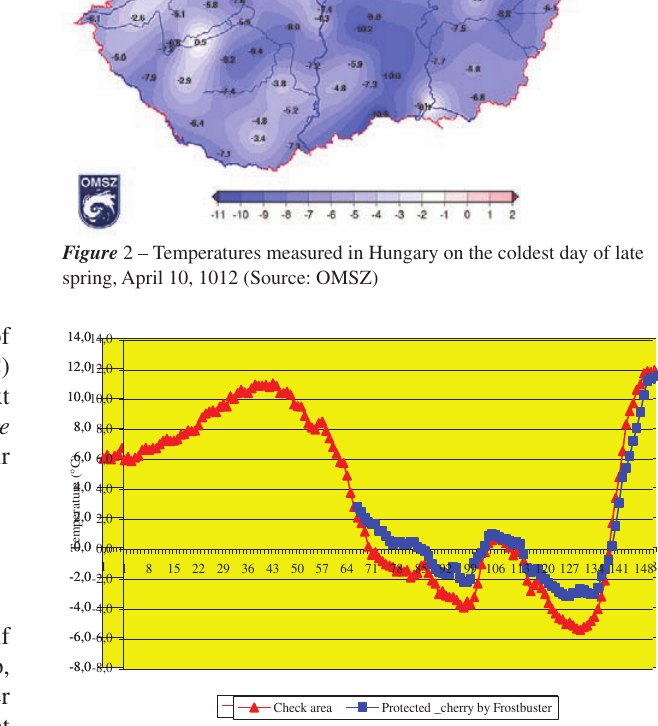
Figure 3 – Temperatures measured in the intense cherry plantation protected by the Frostbuster (blue) and in the check area (red) during the days April 9 and 10, 1012 (between 09.00 and 09.00